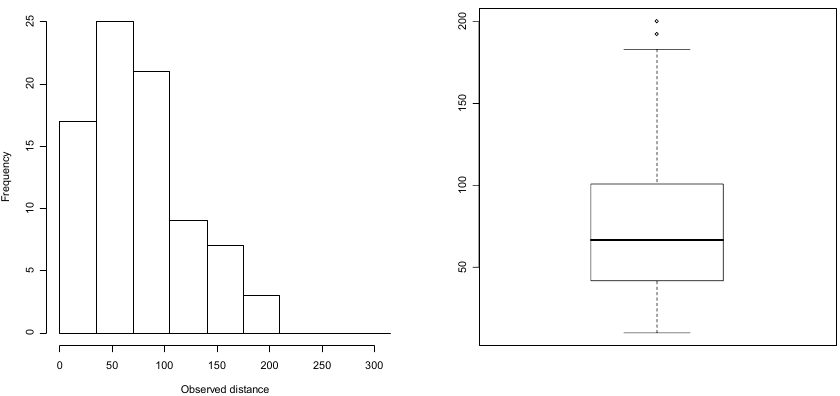
Figure 2 − Distribution of the observed distances for the chipping sparrow data in burn